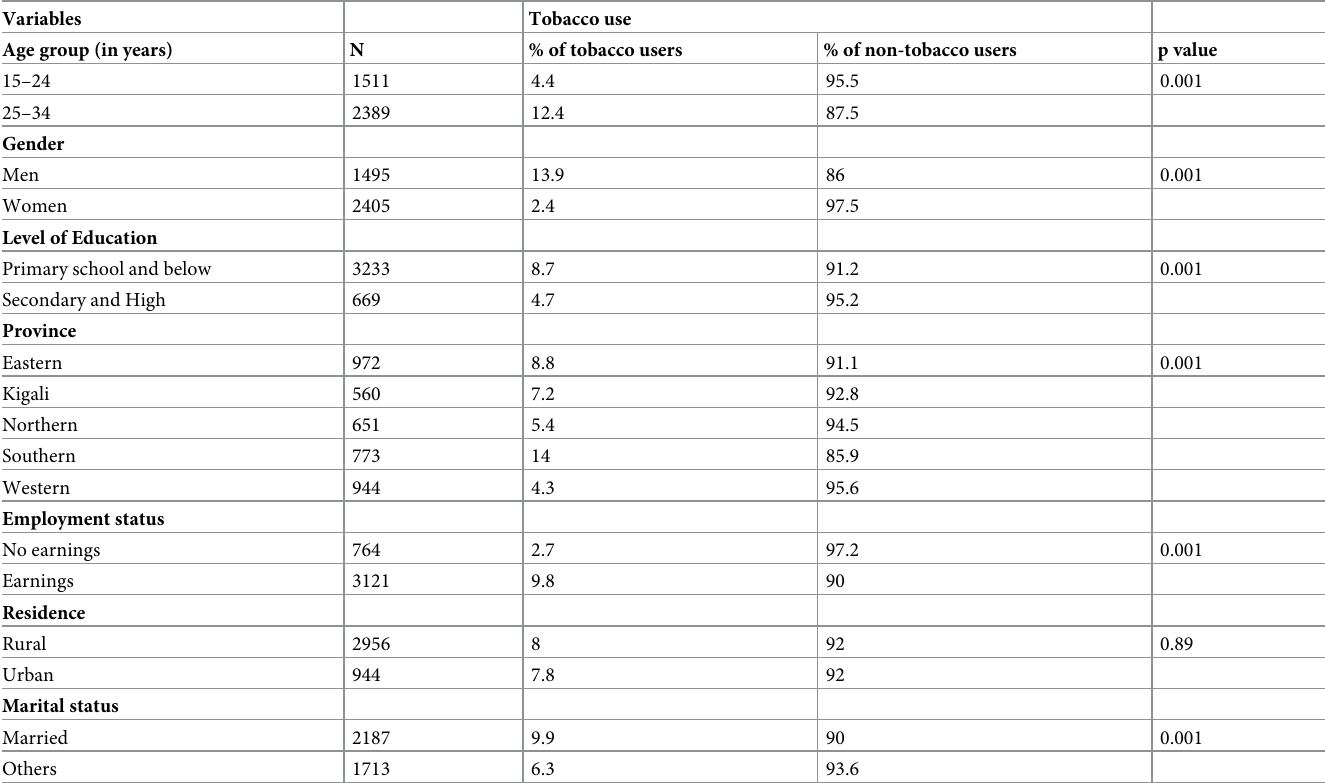
Table 1. Socio-demographic characteristics by tobacco use (N =